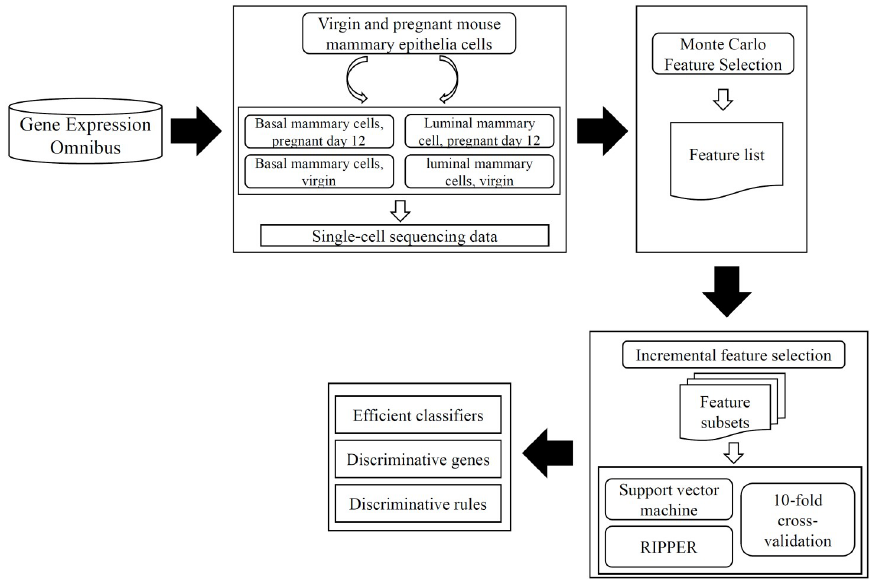
Fig 1. Entire procedures to analyze the single-cell sequencing data for virgin and pregnant mouse mammary epithelia cells. The data is retrieved from Gene Expression Omnibus. Powerful Monte Carlo Feature Selection is applied on such data, resulting in a feature list. This list is fed into incremental feature selection, incorporating two classification algorithms, to build efficient classifiers and extract discriminative genes and rules.